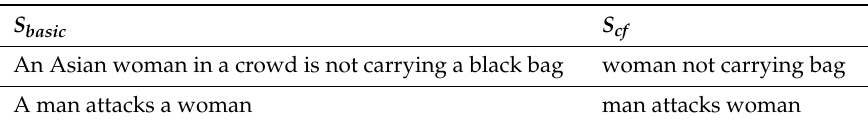
Table 1. Examples of basic part S basic and component-enhanced part S cf